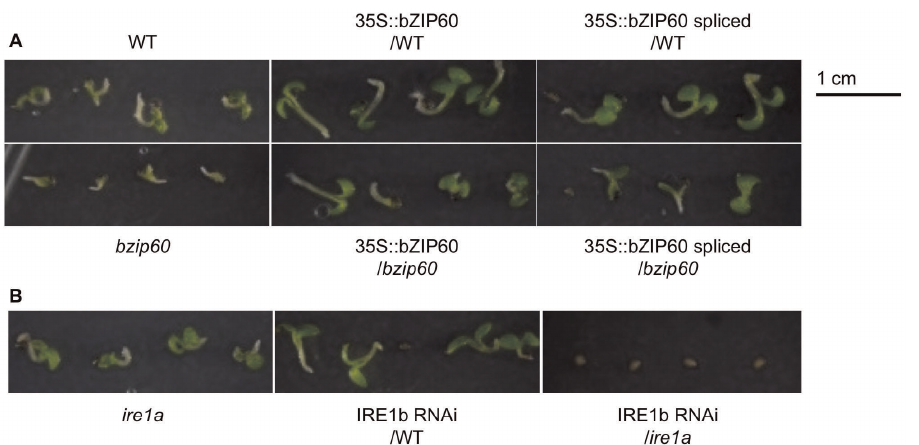
Figure 5. Phenotype of transgenic and mutant seedlings grown for 7 days on MS medium supplemented with 2.5 mM DTT. A. WT, bzip60 mutant and transgenic lines over-expressing full-length or spliced bZIP60 variants in WT and bzip60 backgrounds. B. ire1a mutant and IRE1b RNAi lines in WT and ire1a backgrounds. One representative line is shown for each transformed construct.